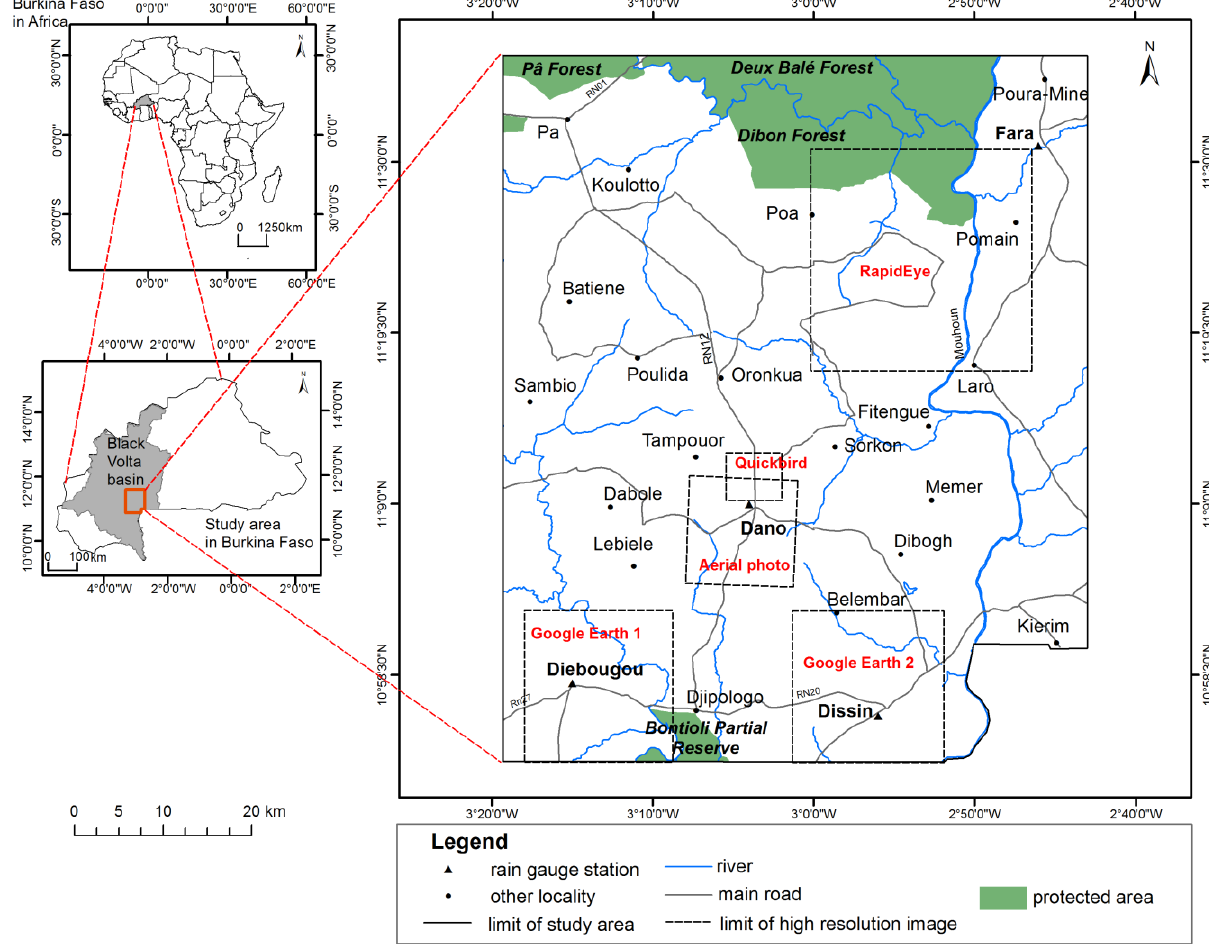
Figure 1. Situation of the study